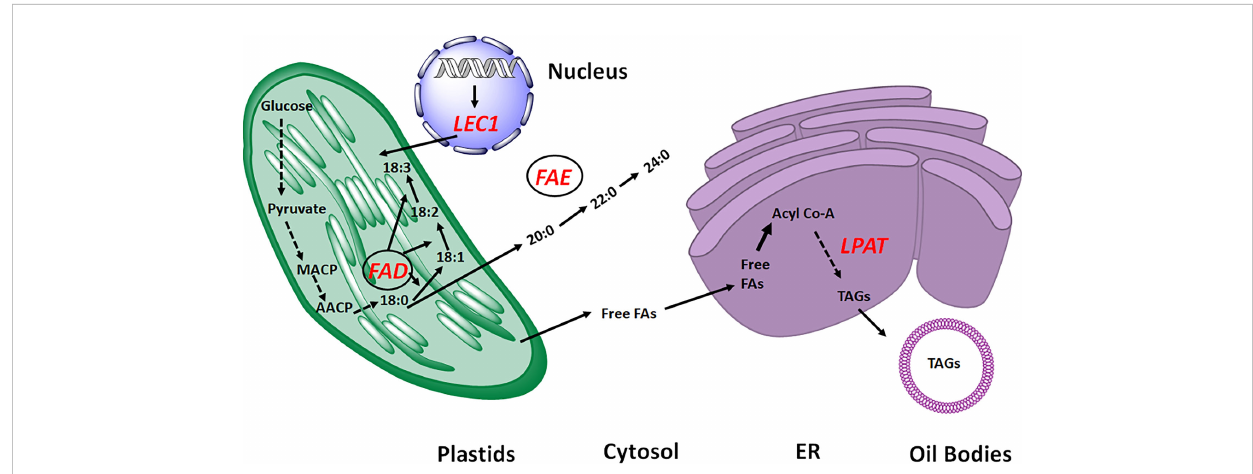
FIGURE 2 Overview of Fatty acid biosynthesis pathway. The genes targeted for seed oil improvement in Brassica napus by CRISPR technology are highlighted as red. FFAs, free fatty acids; MACP, Malonyle ACP; AACP, Acyle ACP; LPAT , Lysophosphatidic acid acyltransferase; FAE , Fatty acid elongase; LEC1 , Leafy cotyledon; FAD , Fatty acid desaturase; ER, Endoplasmic Reticulum.